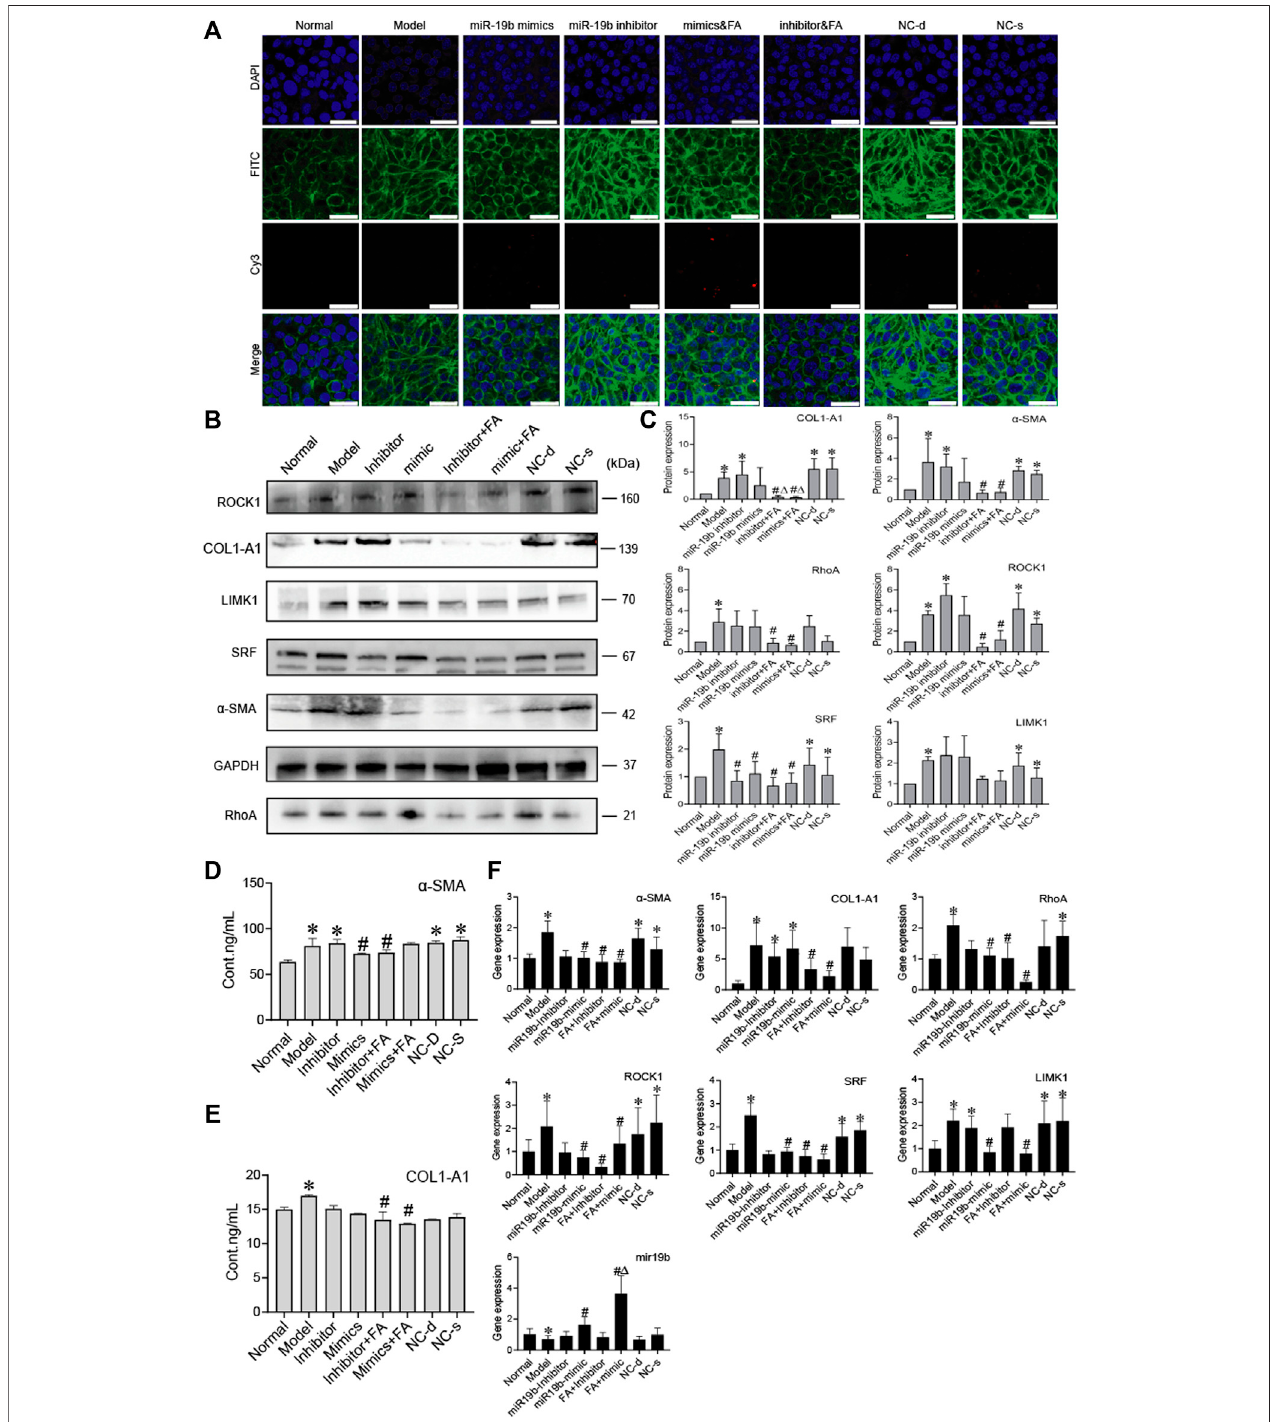
FIGURE 7 | FA induces BMSCs to release more miR-19b-3p to HSCs and inhibit the activation of HSCs. (A) Representative images of the cytoskeleton (green) in theHSCstreatedwithmiR19b-3pmimics,inhibitor,orNC-dandNC-s.DAPIwasusedtostaincellnuclei(originalmagni fi cation,×40;scalebars:25 μ m). (B , C) Western blot bands and cumulative densitometric analyses of each group (normal, model, inhibitor, mimic, inhibitor&FA, mimic&FA, NC-d, NC-s). Data are presented as the mean ± SEM ( n = 3 independent experiments, Two-way ANOVA; * p < 0.05, versus the normal group; # p < 0.05, versus the model group; Δ p < 0.05, versus the inhibitor/mimic group). (D , E) The protein content of α -SMA and COL1-A1 in extracellular medium. n = 3 independent experiments, Two-way ANOVA; * p < 0.05 versus the normal group; # p < 0.05 versus the model group; (F) qRT-PCR analysis for α -SMA, COL1-A1, ROCK1, RhoA, SRF, and LIMK1 in HSCs. n = 3 independent experiments, Two-way ANOVA; * p < 0.05 versus the normal group; # p < 0.05 versus the model group; Δ p < 0.05 versus the miR19b mimic group.